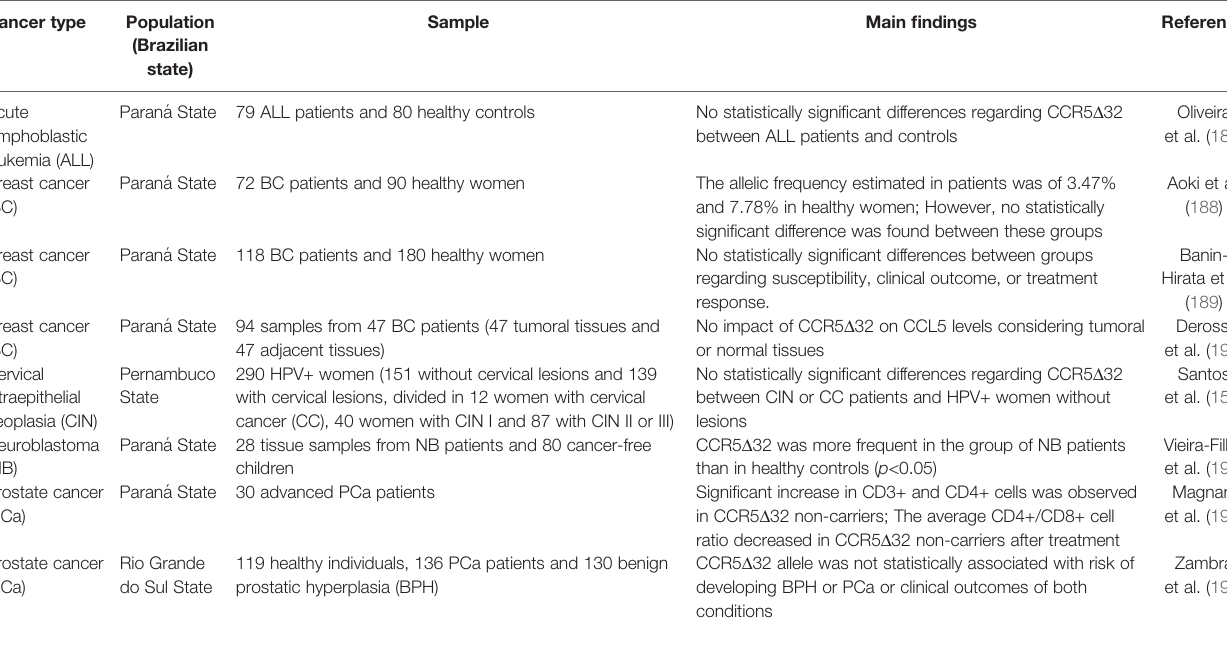
TABLE 4 | Impacts of the CCR5 D 32 on